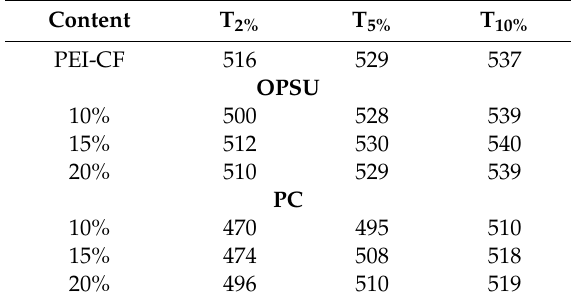
Table 6. Heat resistance of carbon-filled PEI with different content of OPSU and PC. С ontent Т 2%